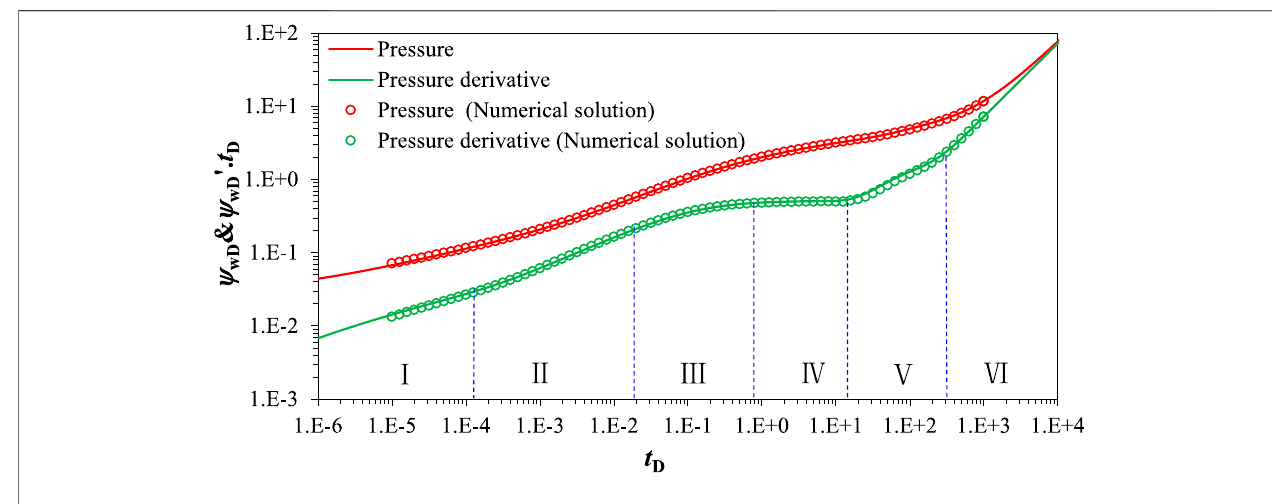
FIGURE 5 | Wellbore pressure comparison curves.